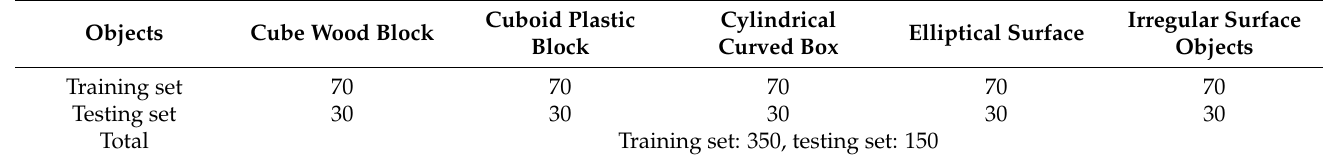
Table 1. Dataset division.